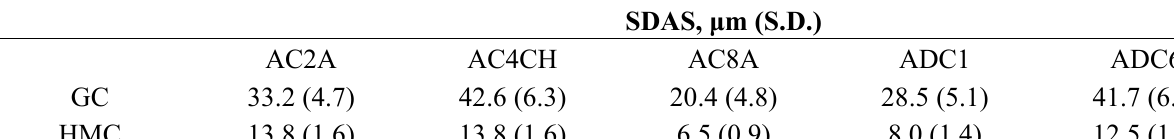
Table 2. Secondary dendrite arm spacing (SDAS) of cast aluminum alloys.